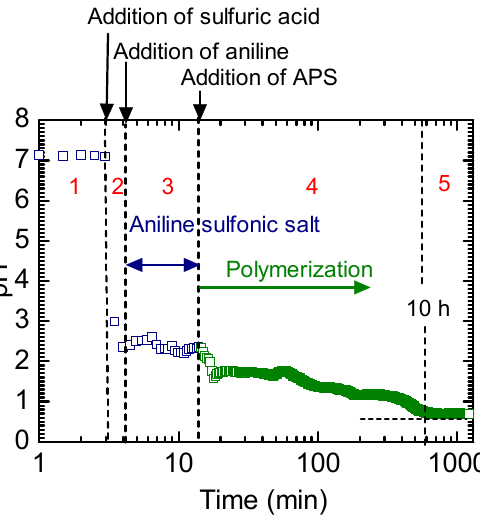
Figure 1. Change in pH during polymerization. Step 1: The seawater pH values before the reaction. Step 2: The change in pH after the addition of sulfuric acid. Step 3: The change in pH after the addition of ammonium peroxodisulfate (APS). Step 4: The change in pH after the addition of APS to the polymerization process to obtain polyaniline. Step 5: The completion of polymerization. The solution pH value was stabilized. The steps are designated with red colored numbers.